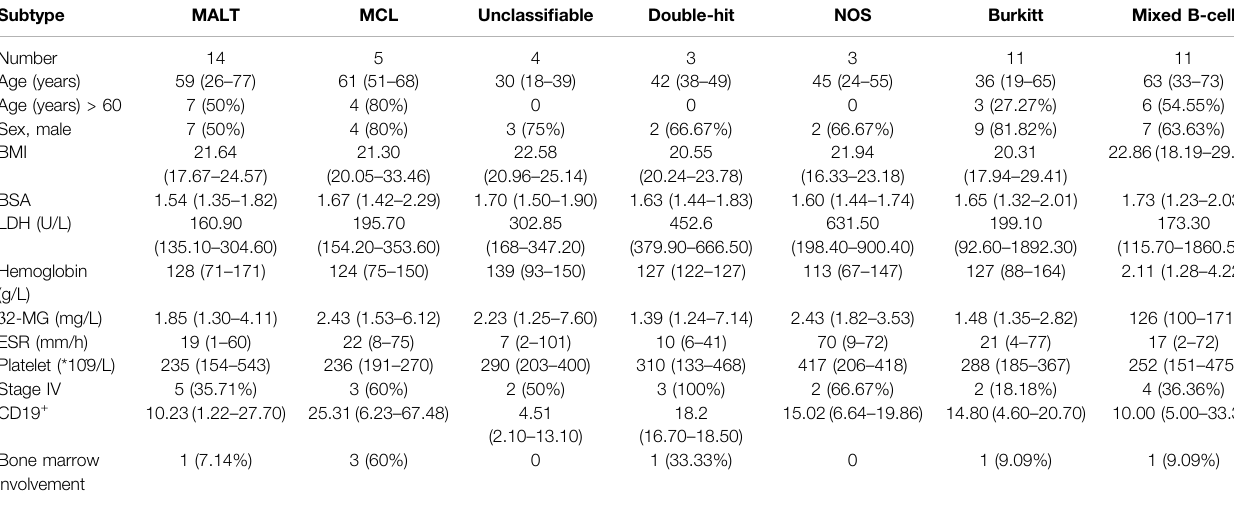
Allcontinuousvaluesarereportedasthemedian(minimum – maximum),categoriesarereportedasnumbers(percentages).MALT,marginalzonelymphoma;MCL,mantlecelllymphoma; Unclassi fi able,unclassi fi ableB-celllymphoma(intermediatebetweenDLBCLandclassicalHodgkin ’ s); “ Double-hit ” ,High-gradeB-celllymphomaswithtranslocationsofMYCandBCL2 and/or BCL6; NOS, high-grade B-cell lymphomas appear blastoid or cases intermediate between DLBCL and Burkitt lymphoma, but which lack an MYC and BCL2 and/or BCL6 rearrangement. BMI, body mass index; BSA, body surface area; LDH, lactate dehydrogenase; β 2-MG, β 2-microglobulin; ESR, erythrocyte sedimentation rate; CD19 + , the baseline proportion of CD19 + cells relative to the total number of lymphocytes in peripheral